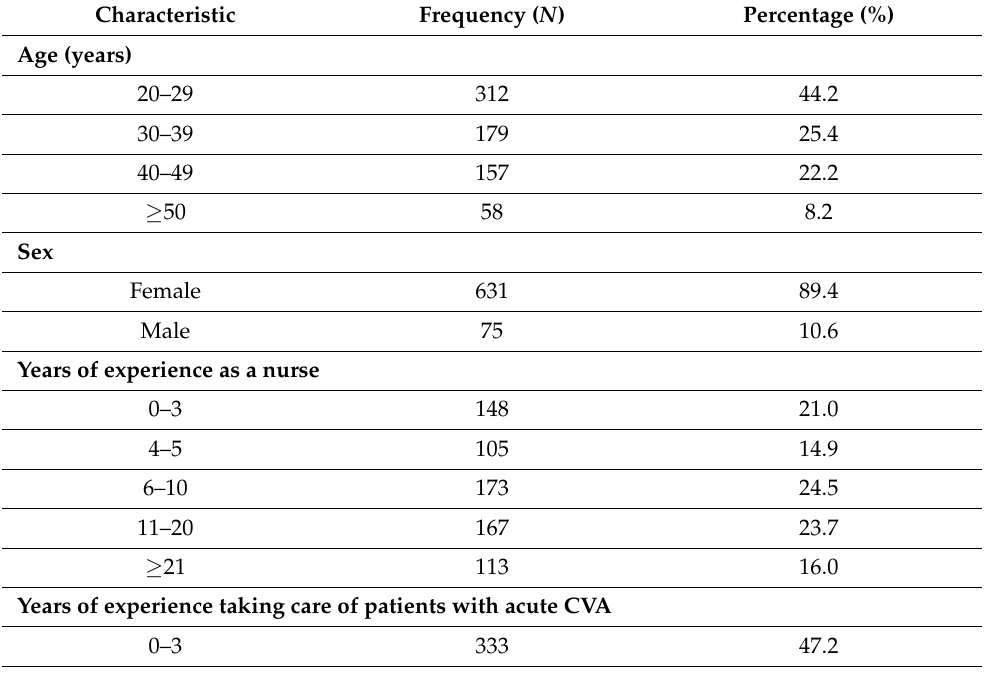
Table 1. Participants’ demographic characteristics ( N =